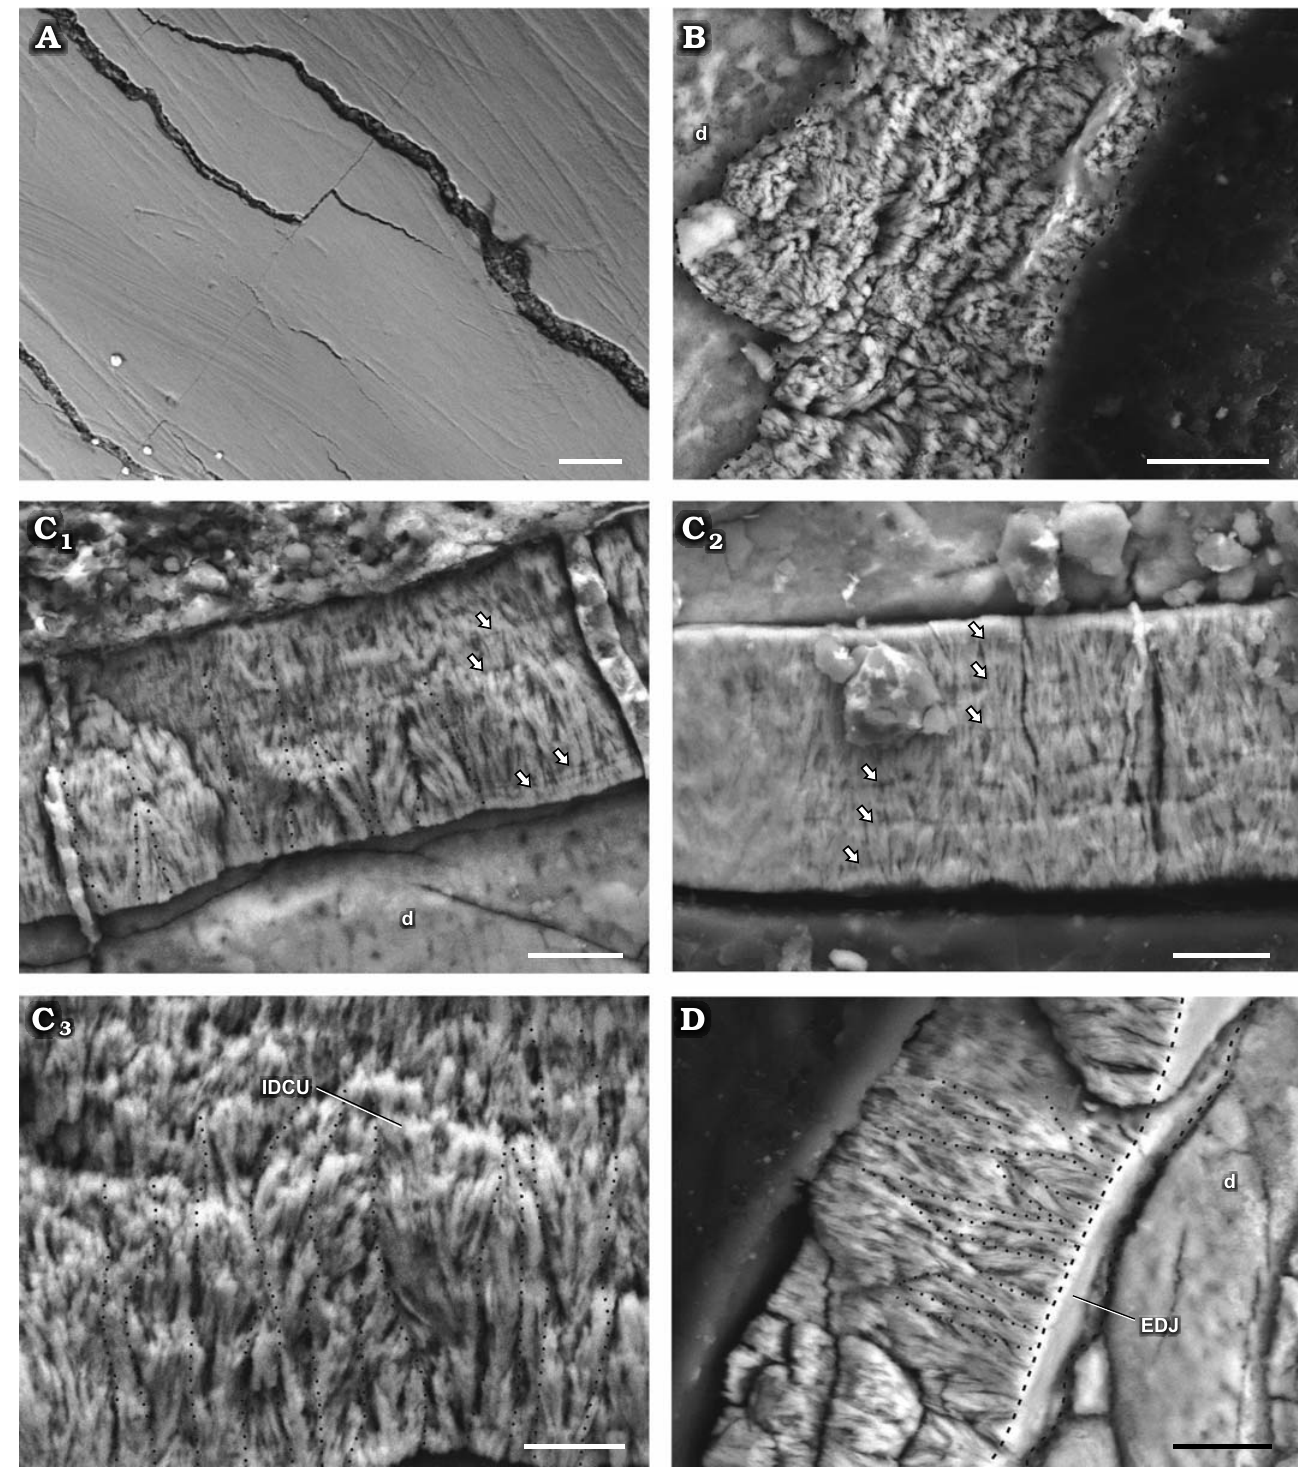
Fig. 4. Enamel in isolated dentary teeth of a basal ornithischian Manidens condorensis Pol, Rauhut, and Becerra, 2011 from Cañadón Asfalto Formation (Queso Rallado locality, late Toarcian), Chubut province, Argentina. A . MPEF-PV 3812, detail of the EES. B . MPEF-PV 10865, details of the tangential section. C . MPEF-PV 10863, cross-sections (C 1 –C 3 ). D . MPEF-PV 10862, longitudinal section. Arrows point to IL, dot lines separate different IDCU, dashed lines indicate the limits of the EDJ in oblique view. Abbreviations: d, dentine; EDJ, enamel-dentine junction; EES, external enamel surface; IDCU, incipient divergent columnar units; IL, incrementing lines. Scale bars 10 μ